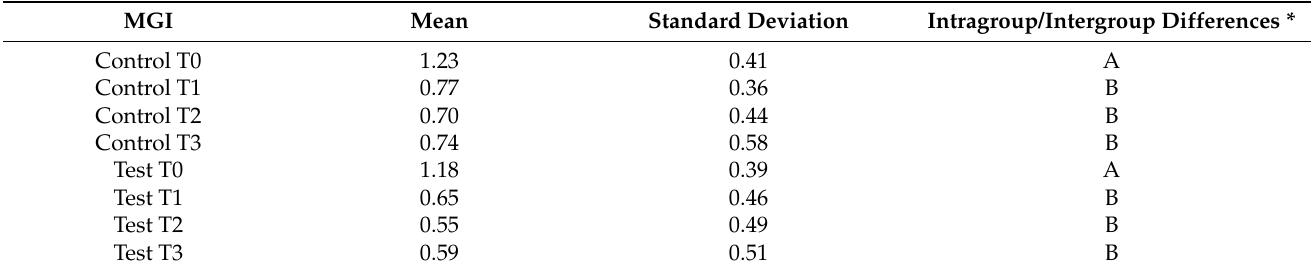
Table 3. Descriptive statistics of MGI results.